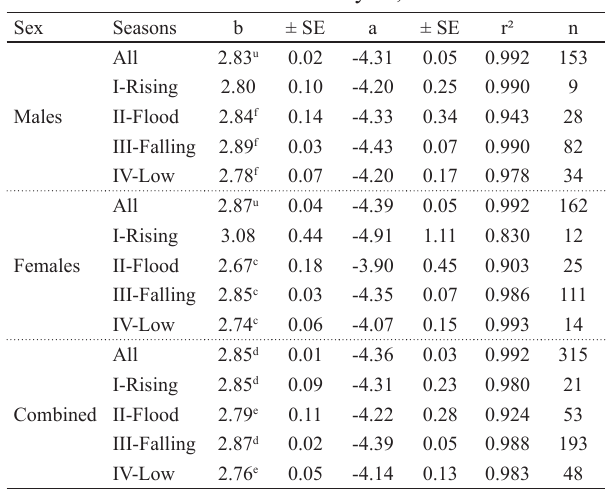
correspond to when black prochilodus